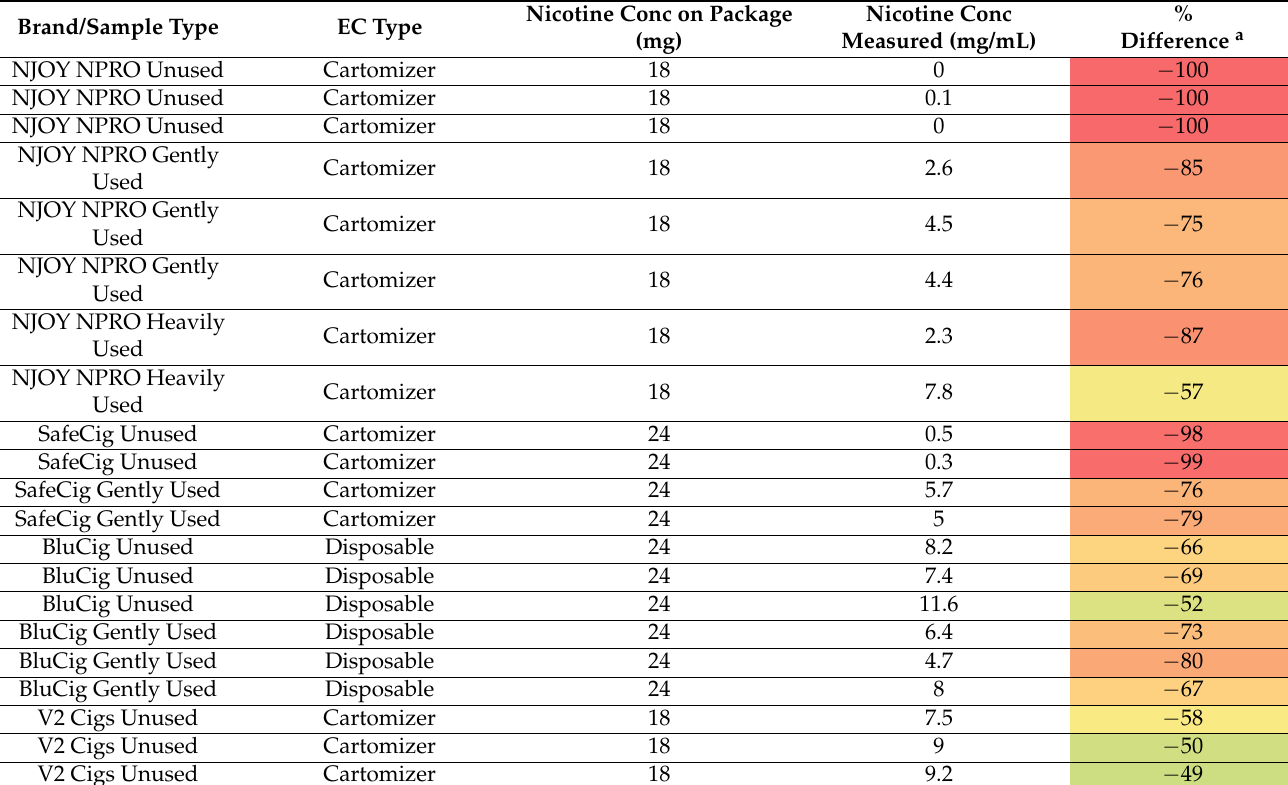
Table 2. Nicotine concentrations in aged unused and used